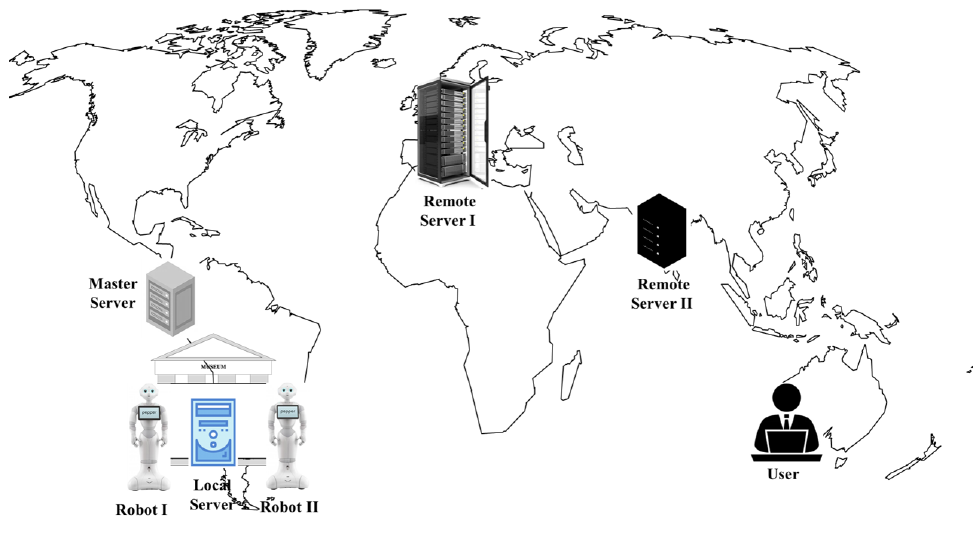
Figure 1. A museum scenario with IoT